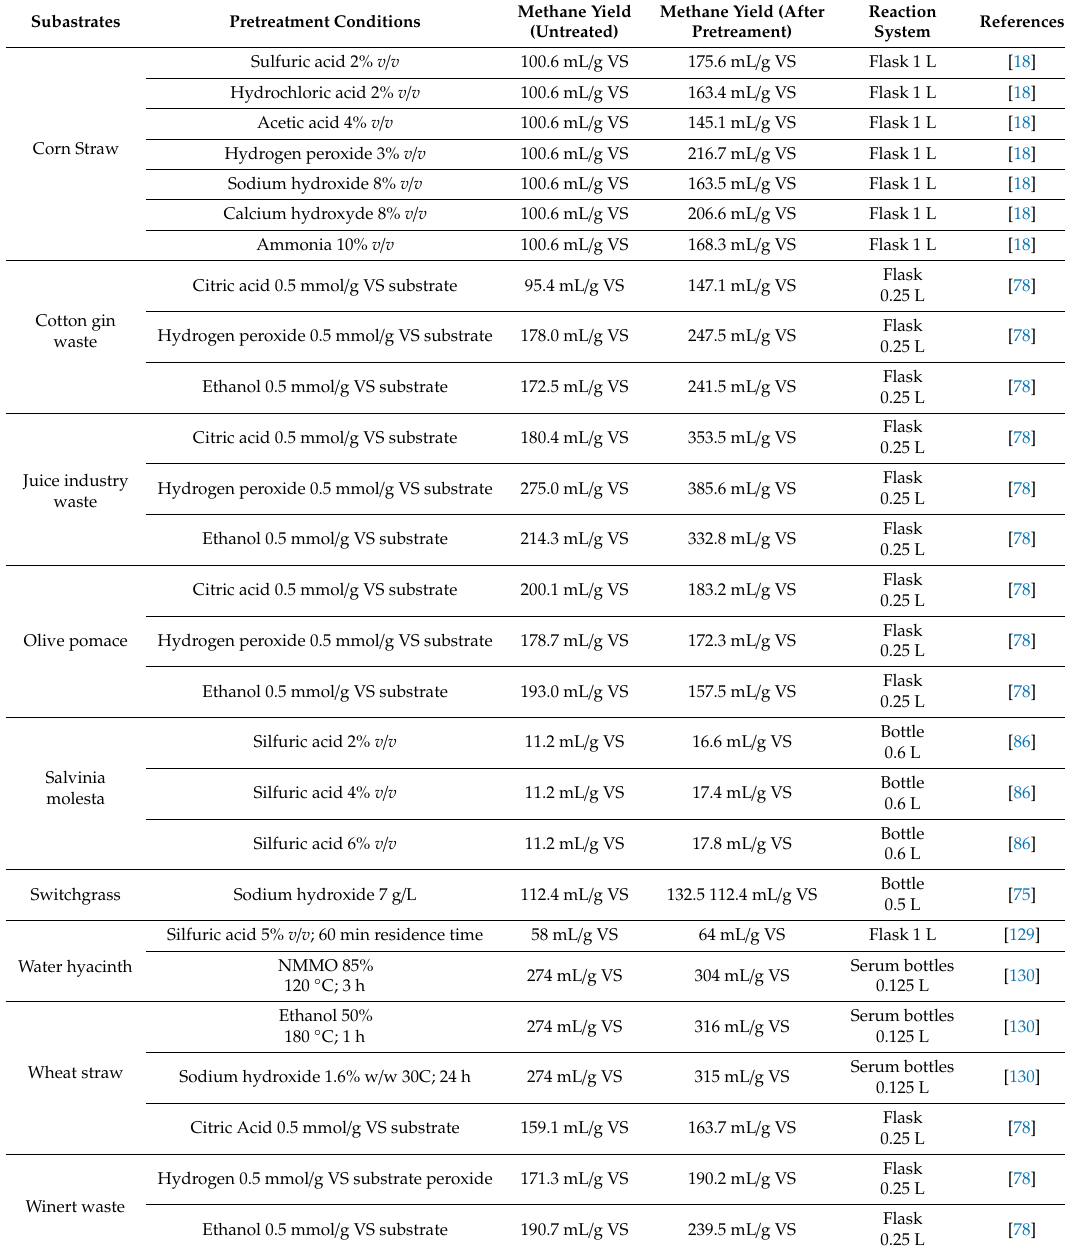
E ff ect of di ff erent chemical pretreatments on methane yield from di ff erent lignocellulosic